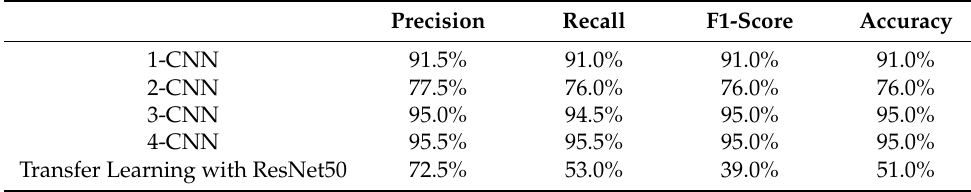
Table 2. Classification report of DL models.